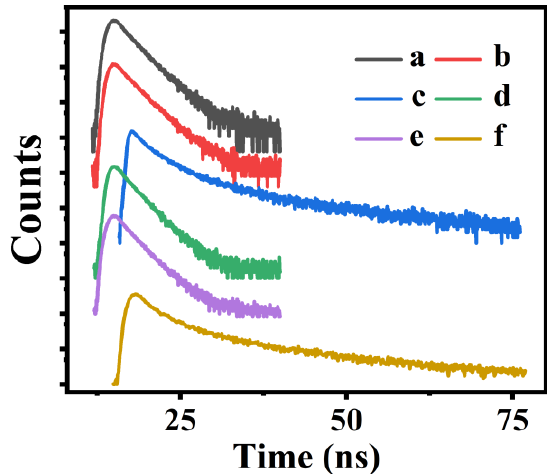
Figure 2. Time-resolved decay profiles and corresponding decayed time (insert) of (a) P(NA- AA)−0−0.1 , (b) P(NA- AA)−0−1 , (c) P(NA- AA)−0−1 0, (d) P(NA- AA)−1−0.1 , (e) P(NA- AA)−7−0.1 , and (f) NA.